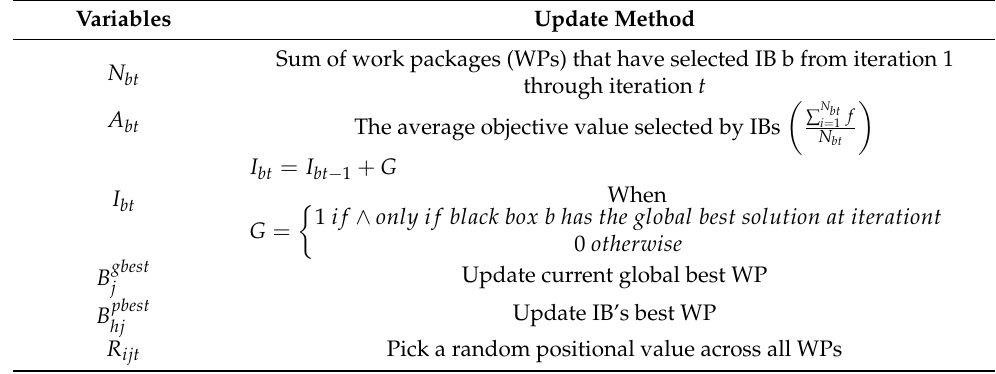
Table 4. Updated role of heuristics